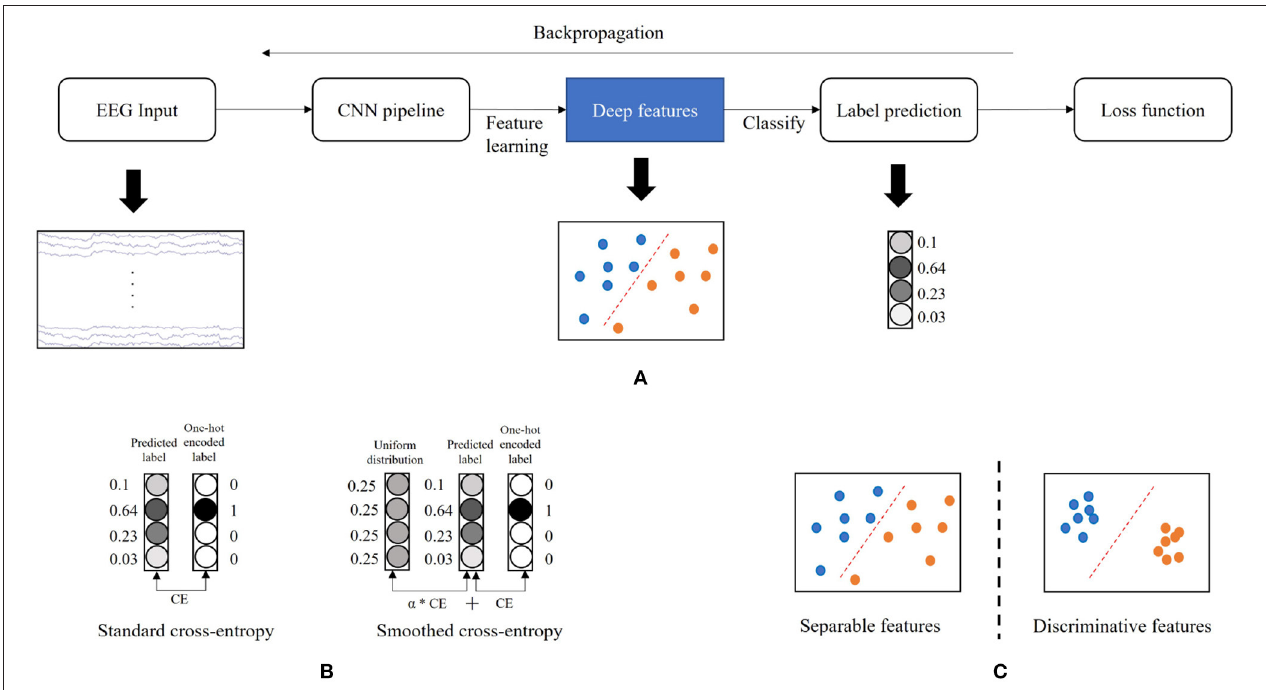
FIGURE 1 | Illustration of the concepts in the study. (A) The common framework of convolutional neural network (CNN). (B) Label smoothing. (C) Deep feature distributions. The CE denotes the cross-entropy calculation. The α denotes the weight of the CE between predicted label and uniform